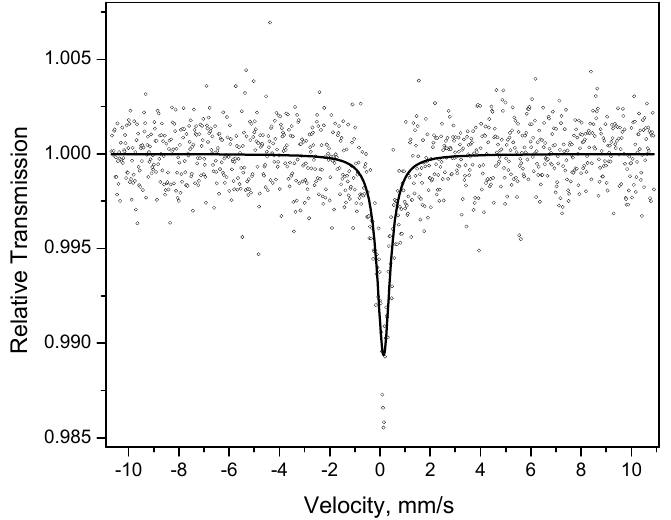
Figure 8. ( a , b ) Morphology of the product of acid treatment of Fe@Pd core–shell particles (hollow particles), different magnifications, ( c ) EDS of the product of acid treatment of Fe@Pd core–shell particles (hollow particles of the Pd-based alloy).